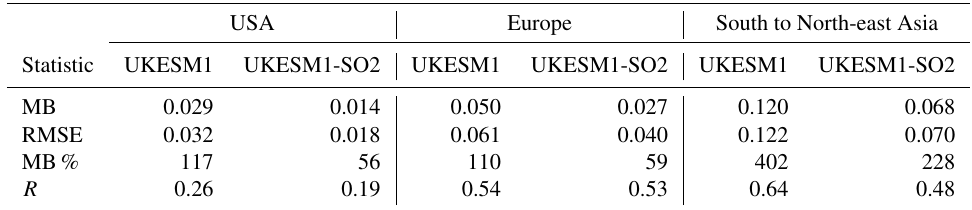
Figure 6. Geographic distribution of mean bias (UKESM1 – obs) in mean annual surface SO 2 and SO 2 ment sites ( N sites = 48 for SO 2 and 42 for SO 2 − ). The mean annual surface concentrations are calculated over the period 1987 to 2014. 4 Absolute mean bias is shown in (a) and (b) and NMB is shown in (c) and (d) . Note that different scales are used for the SO 2 model bias (a) and normalized mean bias (c) . Table 6. Statistics comparing model and OMI total column SO 2 over three regions: USA (60–130 ◦ W, 25–50 ◦ N), Europe (15 ◦ W–40 ◦ E,